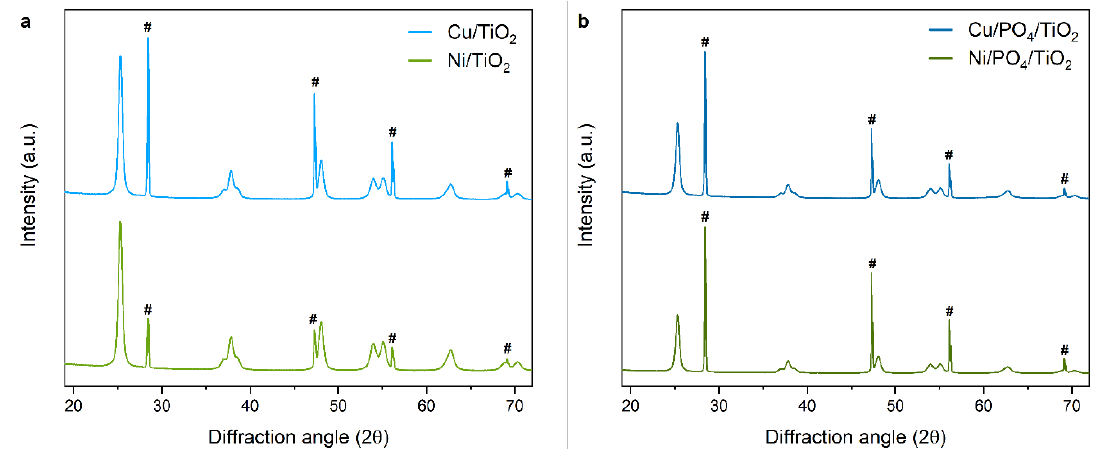
Figure 5. PXRD spectra of ( a ) 5/Cu/TiO 2 and 5/Ni/TiO 2 as well as ( b ) 5/Cu/PO 4 /TiO 2 and 5/Ni/PO 4 /TiO 2 samples. Peaks indicated with correspond to Si. Peaks indicated with # correspond to